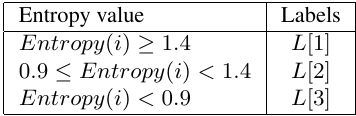
Table 2. Entropy value